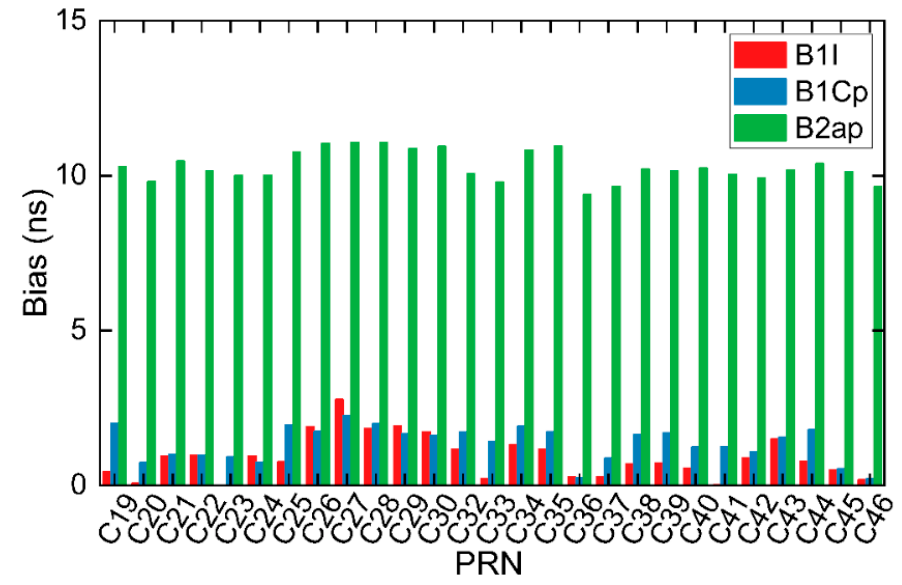
Figure 10. The DCB biases of the PPP-B2b with respect to CAS.